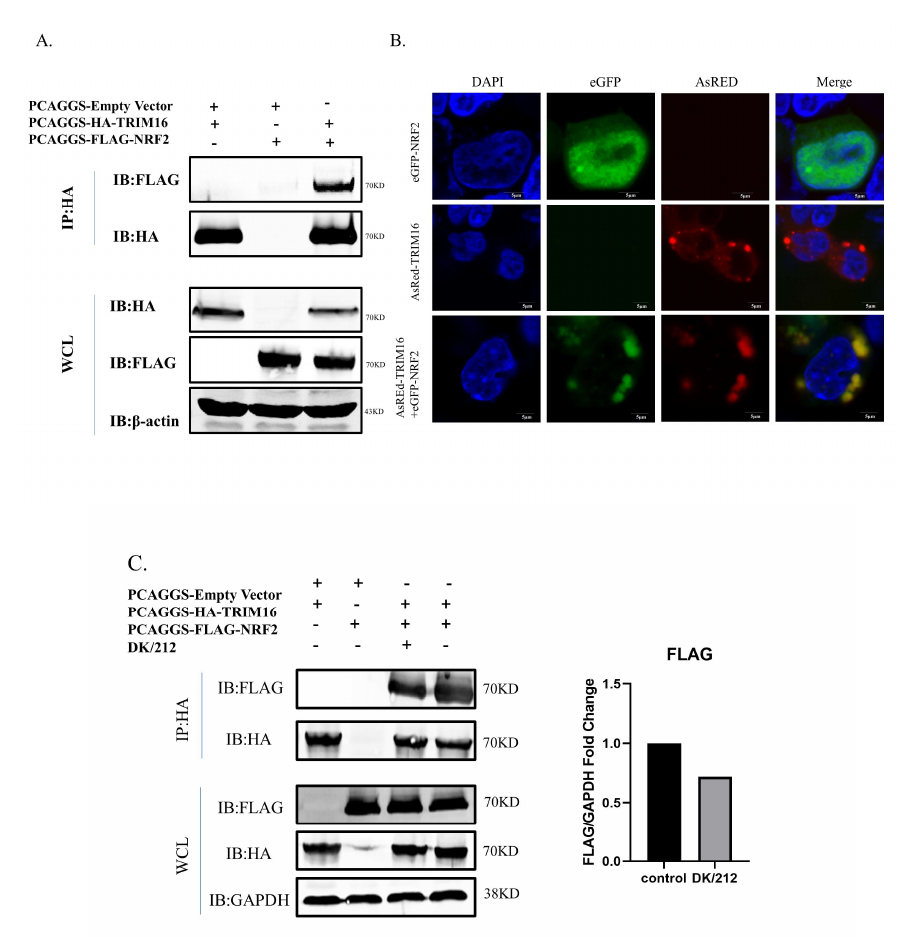
Figure 5. TRIM16 was shown to be an interaction protein of NRF2 and the two proteins were local- ized in the cytoplasm. ( A ) TRIM16 interacted with NRF2 in transfected cells. HEK 293T cells were transfected with PCAGGS-HA-TRIM16 and PCAGGS-FLAG-NRF2. After 24 h, the cells were lysed and immunoprecipitated using anti-HA agarose beads. The interaction was detected by Western blot using an anti-HA and anti-FLAG antibody. ( B ) TRIM16 and NRF2 were colocalized in trans- fected cells. HEK 293T cells were cultured on glass-bottom petri dishes until 50% confluence and were transfected with PCAGGS-AsRed-TRIM16 and PCAGGS-eGFP-NRF2. After 24 h, the trans- fected cells were fixed with cold methanol, stained with DAPI, and visualized by confocal laser scanning microscope. ( C ) After transfection of FLAG-NRF2 and HA-TRIM16 in 293T cells for 24 h, cells infected with DK/212 for 24 h.